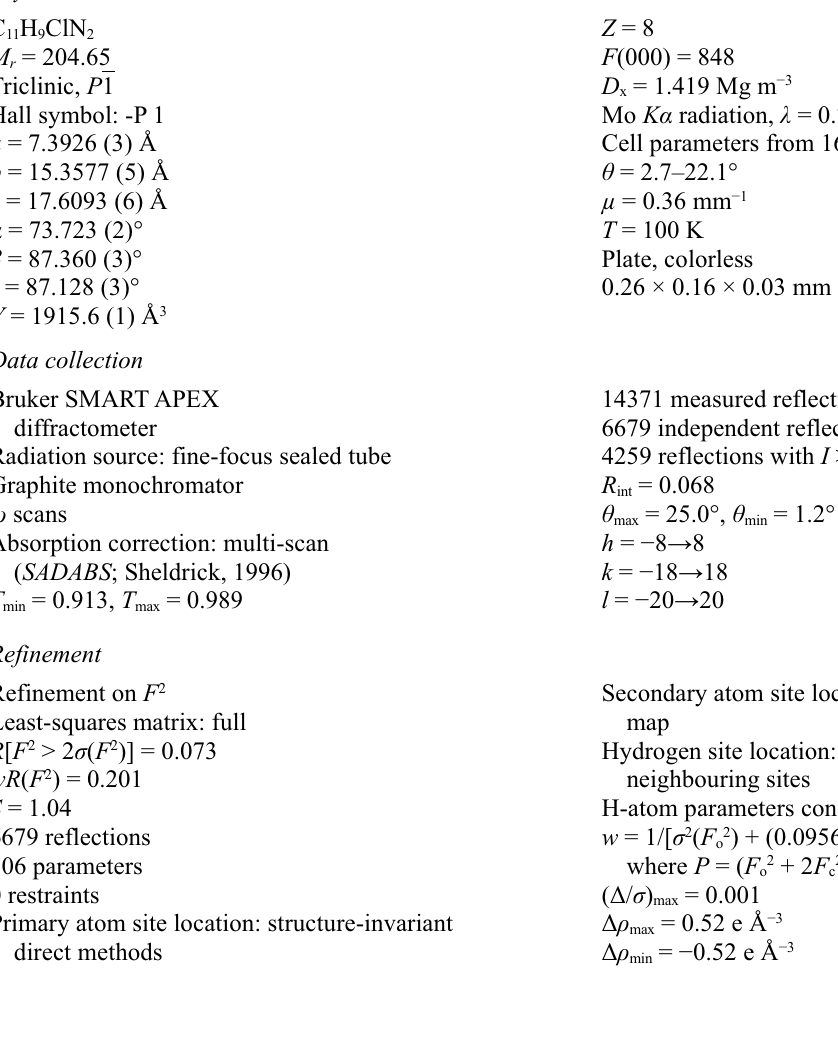
Figure 1 Thermal ellipsoid plot (Barbour, 2001) of the two pairs of hydrogen-bonded C 2-(4-Chloroanilino)pyridine Crystal